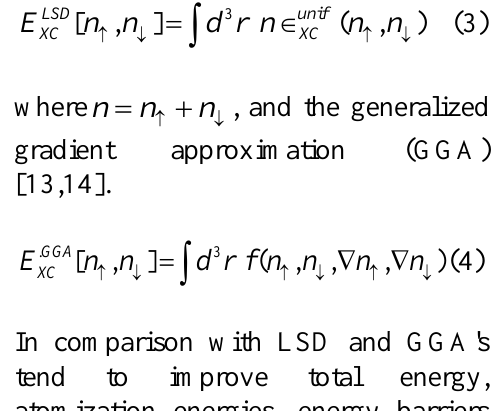
P nanocrystal core as a function of lattice 0.5 0.5 constant.